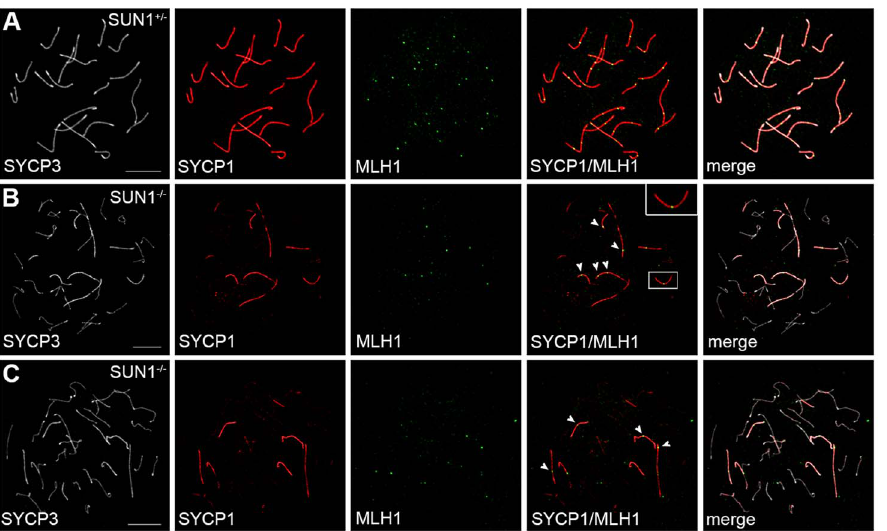
Figure 5. Meiotic recombination in SUN1 deficient oocytes. Representative chromosome spreads of oocytes from 19.5 dpf littermate Sun1 + / + ( D ex10-11) and Sun1 2 / 2 ( D ex10-11) females labeled with anti-SYCP3, anti-SYCP1 and anti-MLH1 antibodies. Complete pairing of all homologous chromosomes as judged by the co-localization of SYCP3 and SYCP1 is observed in heterozygous control pachytene oocytes (A). As expected the homolog pairs exhibit 1–2 distinct MLH1 foci each. In SUN1 deficient pachytene-like oocytes (B, C) only some chromosome stretches and few homologous chromosomes are fully paired. Frequent defects in synapsis formation and many univalent chromosomes can be detected, labeled only by SYCP3. However, distinct MLH1 foci can be observed where SYCP3 and SYCP1 co-localize, (arrowheads in B and C). See also inset in B; magnified by a factor of 2. Scale bars 10 m m.